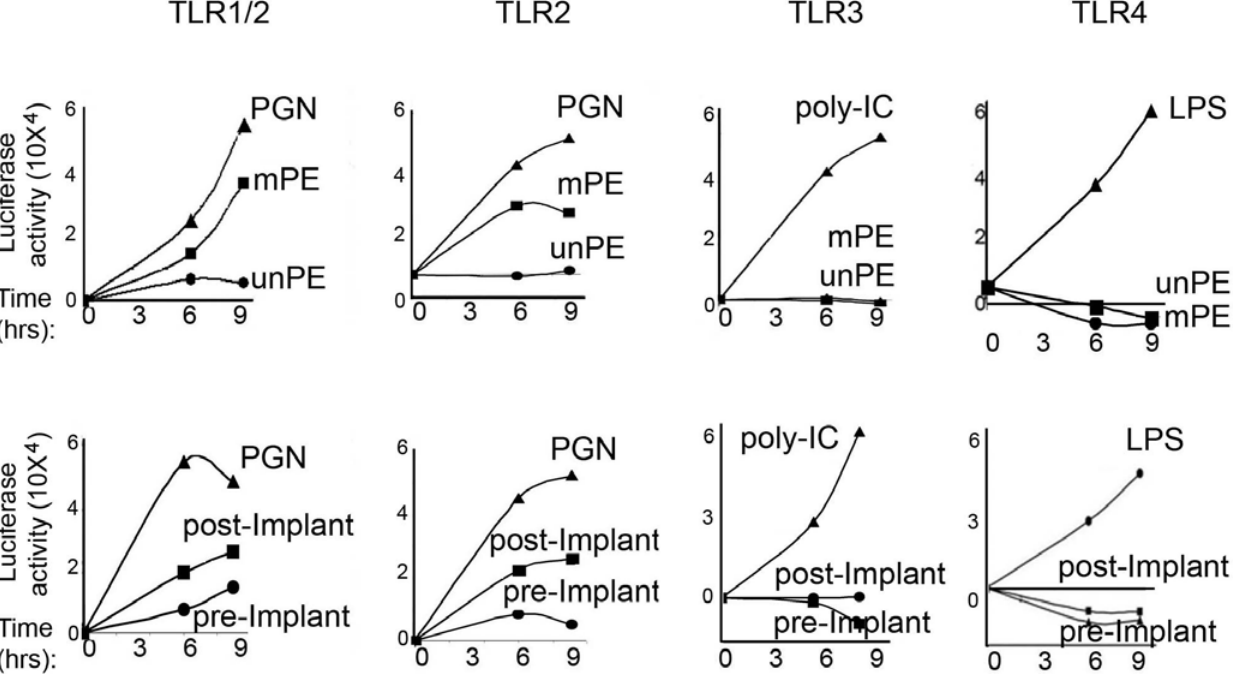
Figure 5. Modified alkane polymers induce activation of TLR-1 and TLR-2 signaling pathways. a) Luciferase activity expressed by human TLR1/2, TLR2, TLR3 and TLR4 stable HEK 3T3 transfectant (pNF- k B-LUC Stratagene). Cells were left untreated or treated for a different time period with 50 m g/ml of unPE, mPE or pre and post implant PE and respective positive controls; PGN(10 m g/ml) for TLR1/2 and TLR2, Poly (I:C)(1 m g/ml) for TLR3 and LPS (10 m g/ml) for TLR4.